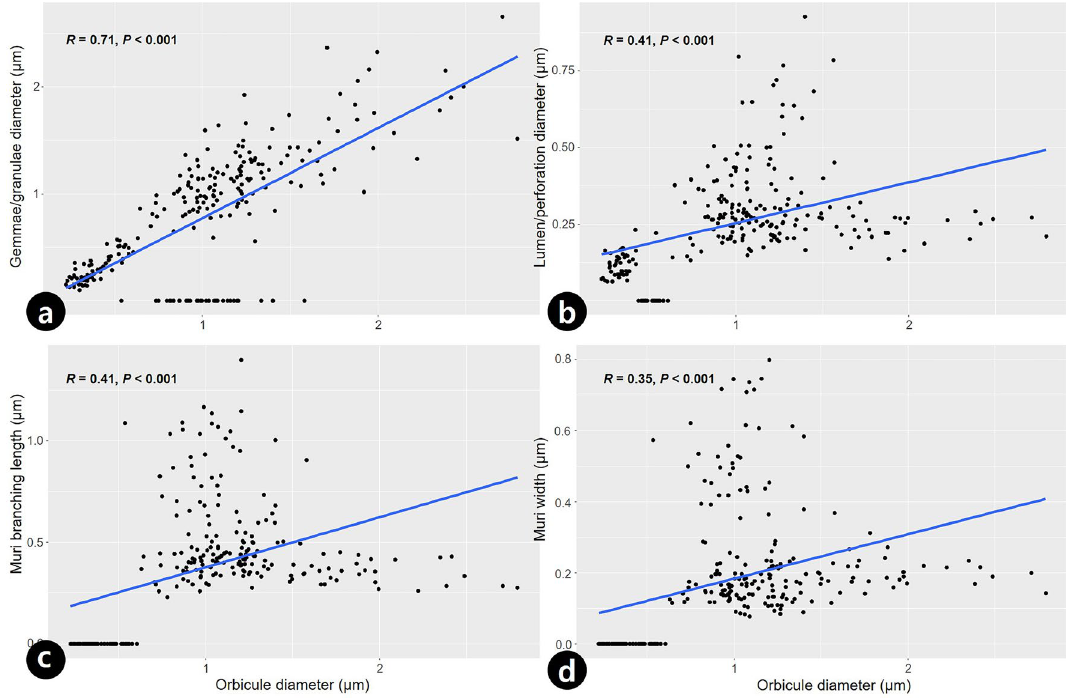
Figure 6. Simple scatter plots of the relationship between orbicule diameter and pollen surface variables (blue line showed regression line) in taxa of Korean Piperales. ( a ) Gemmae/granula diameter ( r = 0.71, P < 0.001). ( b ) Lumen/perforation diameter ( r = 0.41, P < 0.001). ( c ) Muri branching length ( r = 0.41, P < 0.001). ( d ) Muri width ( r = 0.35, P < 0.001) according to orbicule diameter.